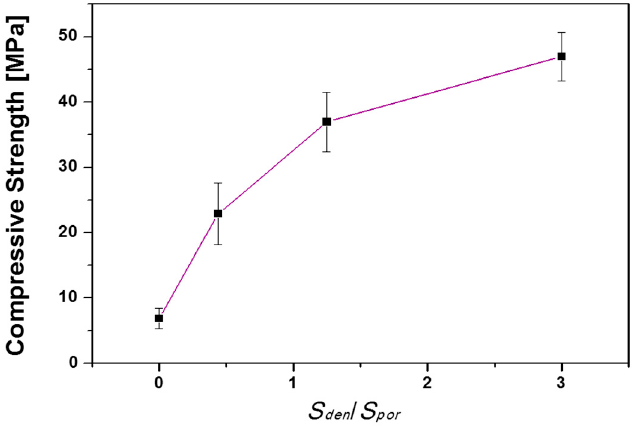
Figure 9. Compressive strength of porous HA scaffolds with bone-like structures as a function of S den / S por .